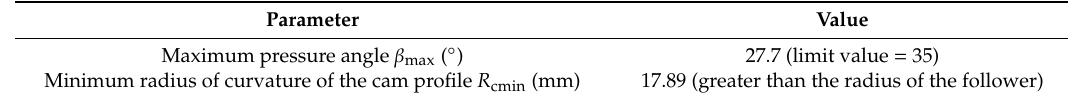
Table 2. Quality indices of the cam-follower mechanism.